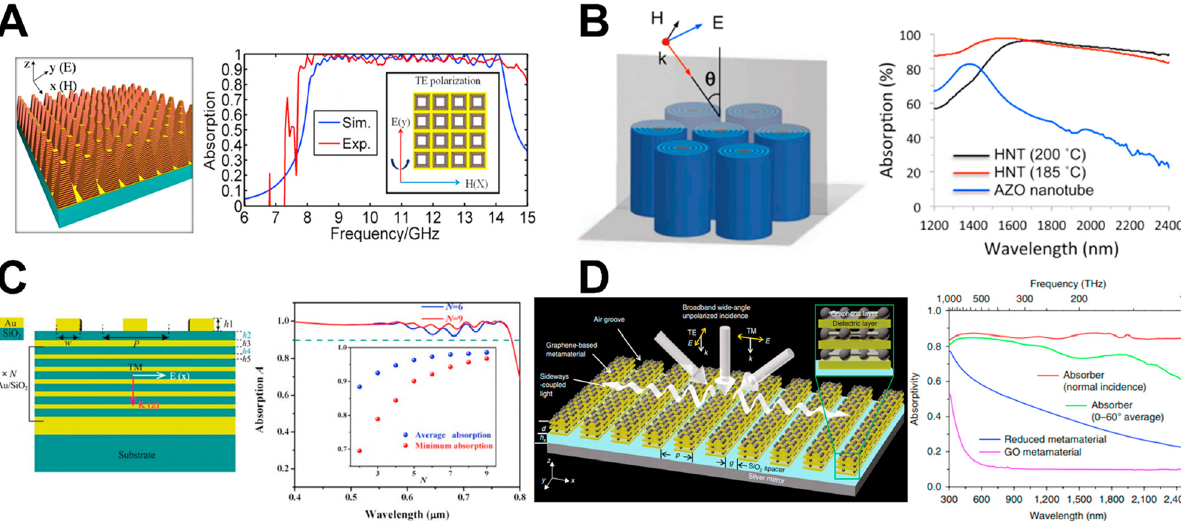
Figure 9: Other broadband absorber designs. (A) A tapered metal/dielectric multilayer structure array, which shows broadband microwave absorption. Adapted with permission from Ref. [118]. Copyright 2012, AIP Publishing. (B) An array of hyperbolic metamaterial cylinders composedofZnOandaluminum-dopedZnOconcentriclayersforinfraredabsorption.AdaptedwithpermissionfromRef[120].Copyright2017, NationalAcademyofSciences.(C)AvisiblelightabsorbercomposedofAugratingandAu/SiO 2 multilayerstack.Absorberswithmorethan fi ve Au/SiO 2 pairsshowaverageabsorptions ofmorethan95%invisibleregime.AdaptedwithpermissionfromRef.[121].Copyright2016,Optical Society of America. (D) Ultra-broadband light absorber composed of graphene and polydiallyldimethylammonium (PDDA) chloride multilayer grating. Waveguide mode coupling in grating contributed to broadband absorption of more than 80% in 300 – 2500 nm. Adapted with permission from Ref. [76]. Copyright 2019, Springer